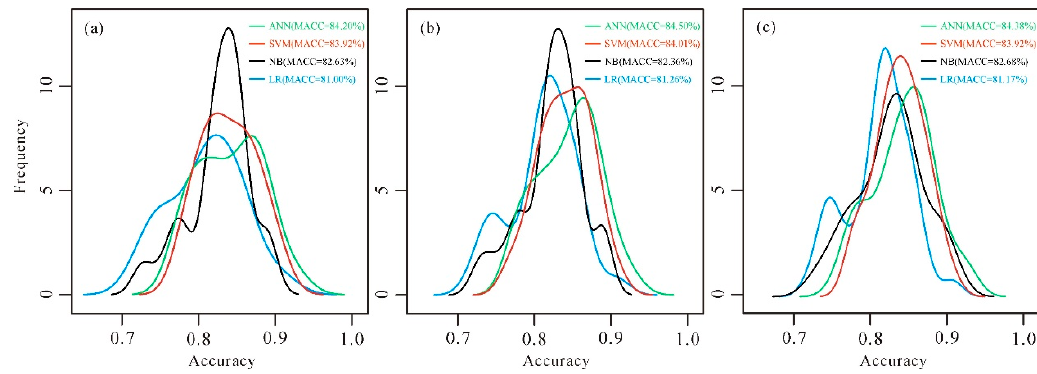
Figure 7. Density curves of base learners ( a ) on 20 resamples, ( b ) on 30 resamples, ( c ) on 40 resamples. MACC: mean accuracy.